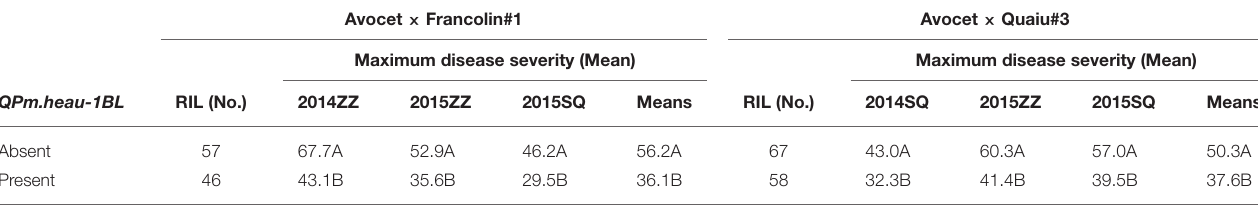
TABLE 5 | t- tests for the comparison of mean maximum disease severity in Avocet × Francolin#1 and Avocet × Quaiu#3 RILs when QPm.heau-1BL was either absent or